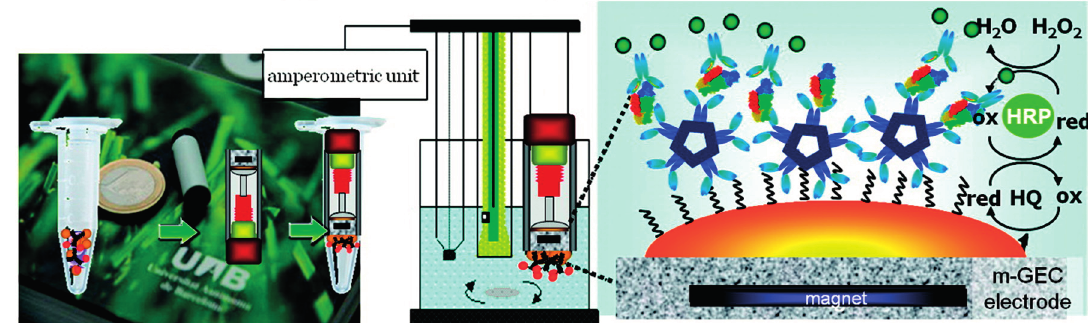
Figure 4. Schematic representation of the experimental details of the P. falciparum antigen (HRP2) related to malaria disease in human serum for the electrochemical magneto immunosensor [148]. Adapted with permission from (de Souza Castilho, M.; Laube, T.; Yamanaka, H.; Alegret, S.; Pividori, M.I. Magneto immunoassays for